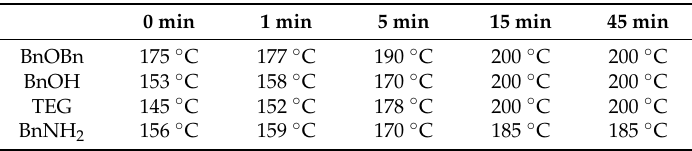
Table A1. Listing of the temperature records during sampling.